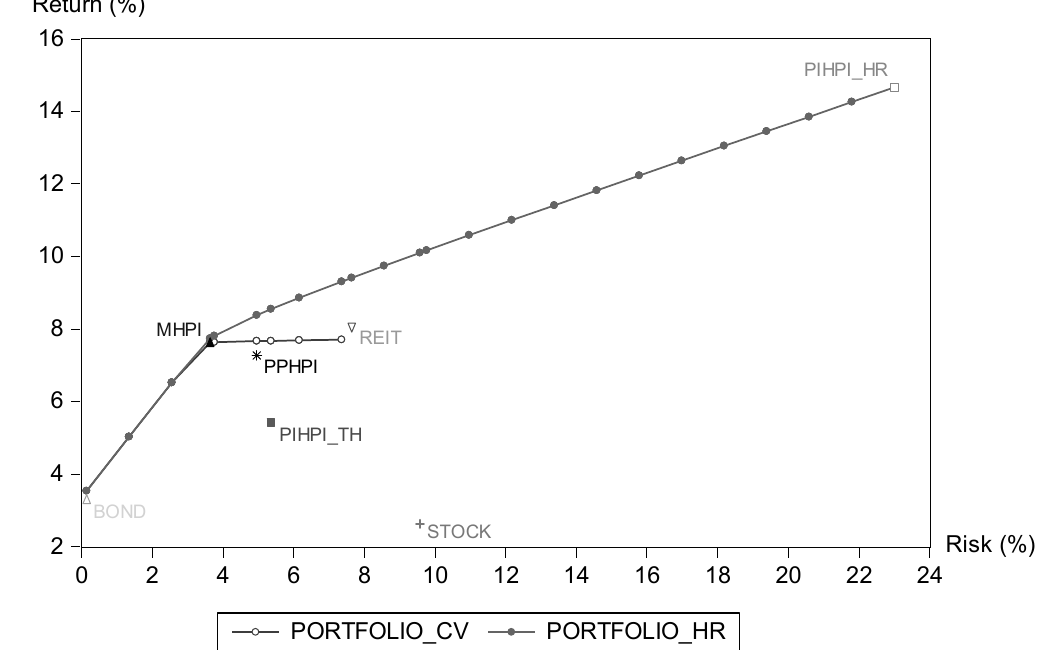
Figure 3. Performance Analysis Between Conventional Portfolio and Diversified Portfolio Based on Efficient Frontiers (2009–2019).